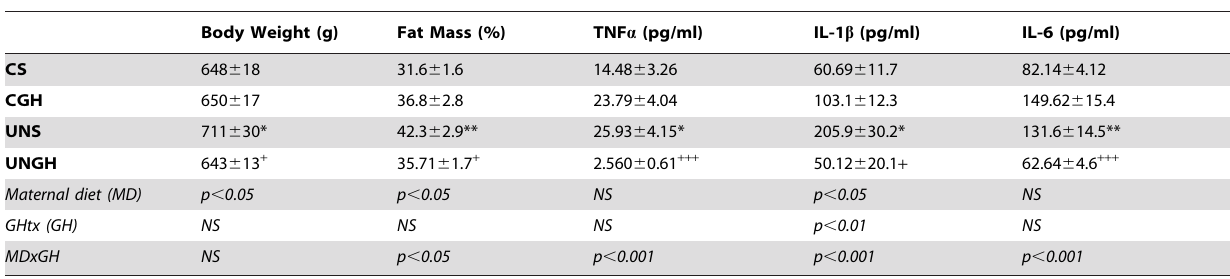
Table 1. Plasma profile.